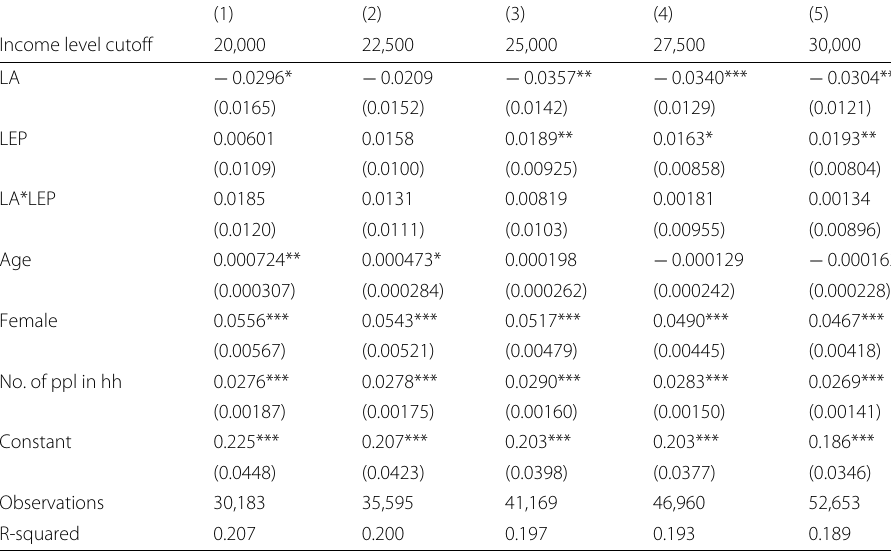
Table 4 Language access and Medicaid take-up rates: 1998–2008